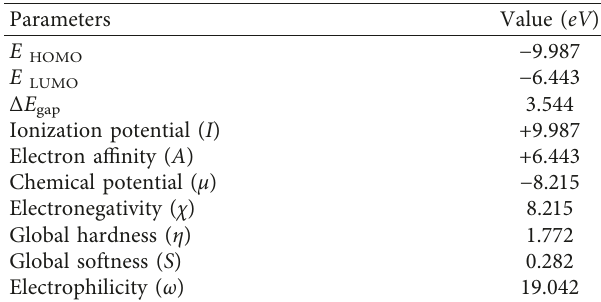
Figure 4: HOMO-LUMO plot of 3M2VPP. Table 4: Chemical descriptors of